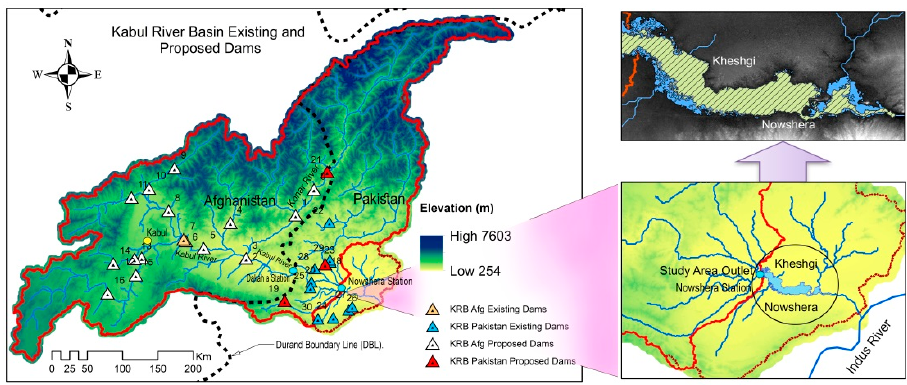
Figure 2. Location of the existing and proposed new dams within the KRB. Table 1. Existing and proposed dams in the KRB (Afghanistan and Pakistan).